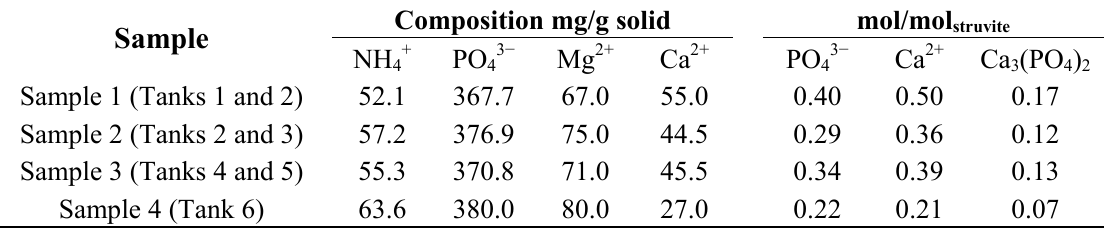
(PO ) produced per mol of 3 4 2